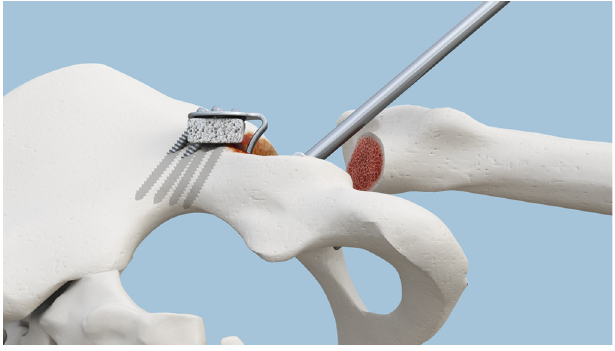
Figure 11. Cemented DMC in place. Figure 9. Fixation completed. Lateral